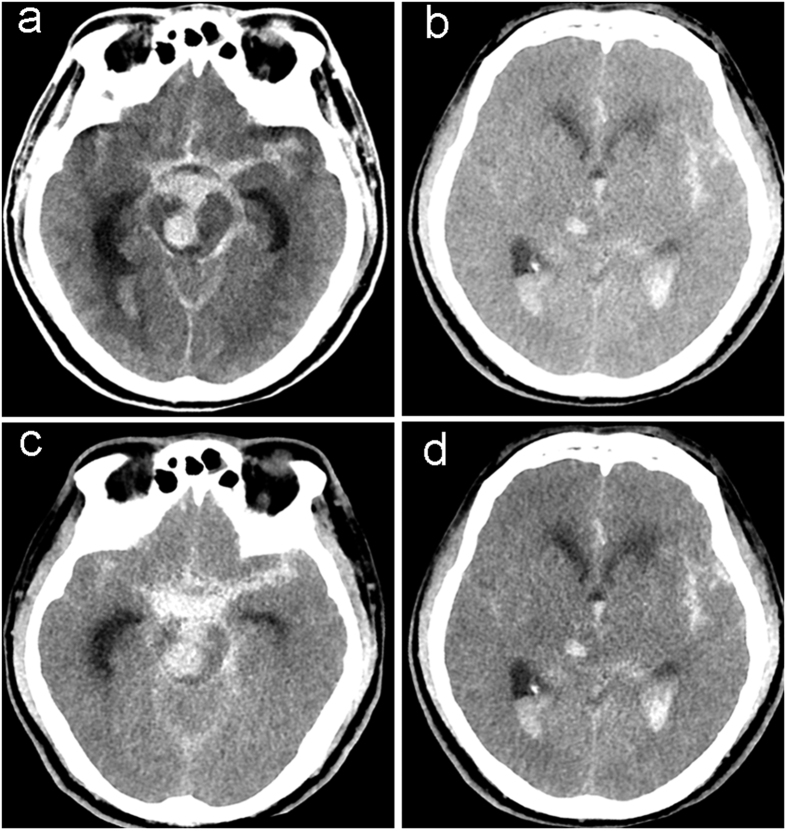
A 59-year-old man with spontaneous subarachnoid hemorrhage and ventricular hematoma caused by ruptured aneurysm of right anterior superior cerebellar artery.(a,b) True non-enhanced CT image, (c,d) virtual non-enhanced CT image.